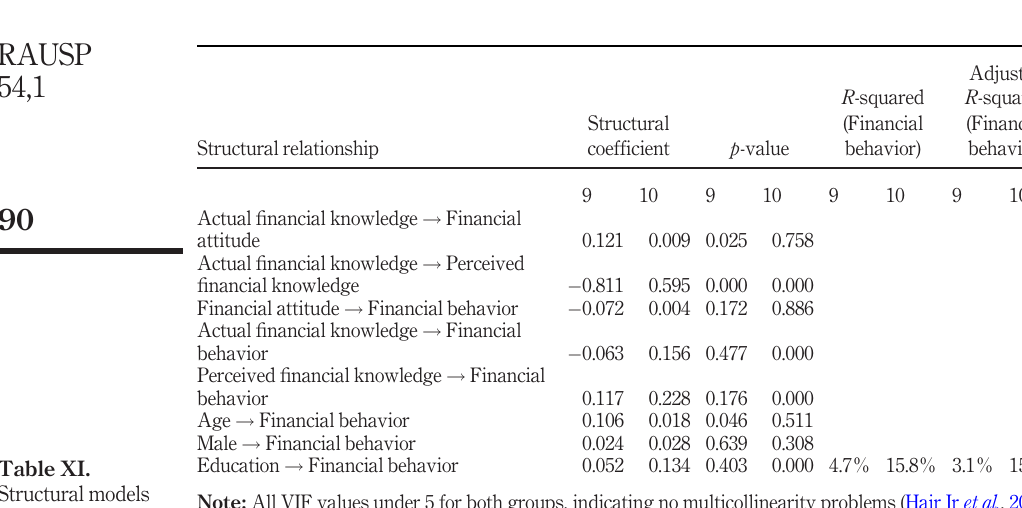
For the over- or under-con fi dent group, its adjusted R -squared (3.1 per cent) was not statistically signi fi cant, indicating that the model does not apply to this group. Furthermore, the multi-group analysis (PLS-MGA) results shown in Table XII validate the statistical signi fi cance of the differences between the structural coef fi cients associated with the relationships between actual fi nancial knowledge and perceived fi nancial knowledge and between actual fi nancial knowledge and fi nancial behavior. Summing up, as was expected after analysis of the correlations between variables, fi nancial attitude was not statistically signi fi cant for any structural relationship. This is also included actual fi nancial knowledge with a positive in fl uence on perceived fi nancial knowledge, in line with the results obtained by Hung et al. (2009a, 2009b); perceived fi nancial knowledge with a positive effect on fi nancial behavior; and actual fi nancial